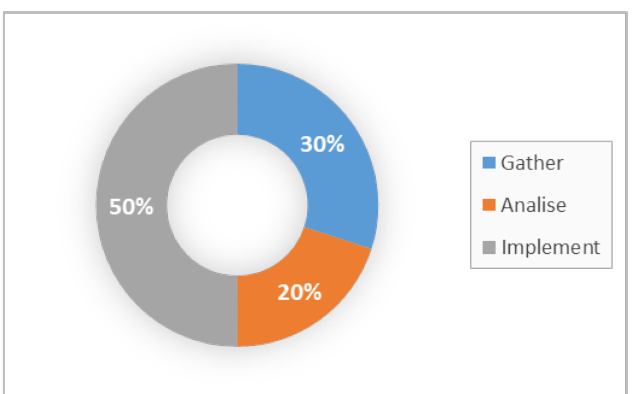
Figure 5. Stage of the GDPR